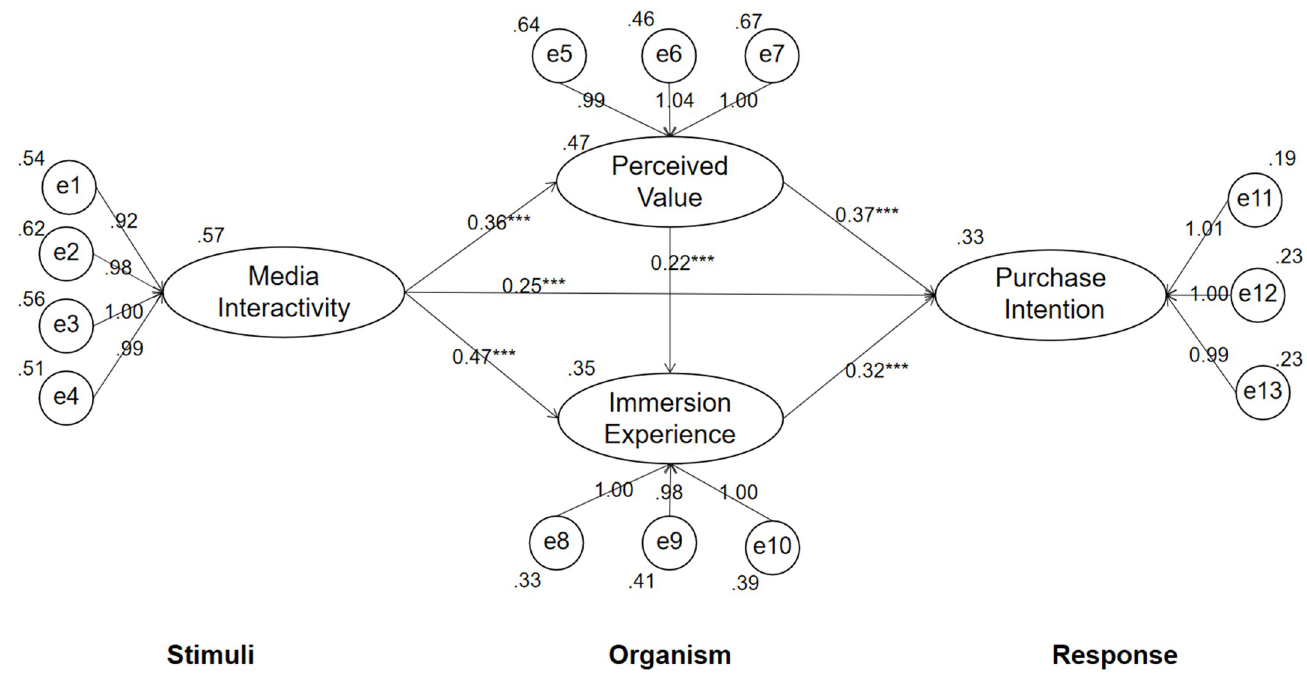
Fig 2. Path diagram of conceptual model.